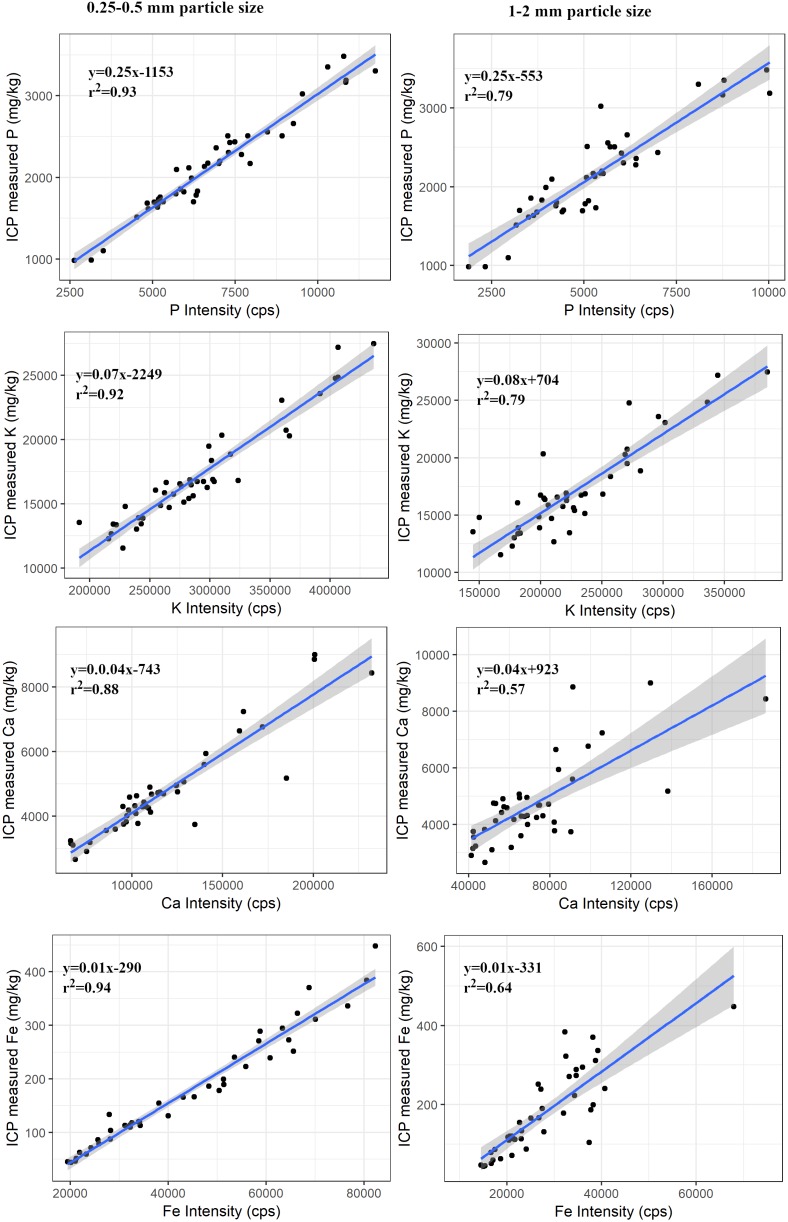
Regression plots between ICP measured concentration and PXRF intensity for P, K, Ca, and Fe for two particle size of forage samples. The shaded portion shows the standard error. The relationship was significant (p < 0.001) for all elements in the samples of both particle sizes.